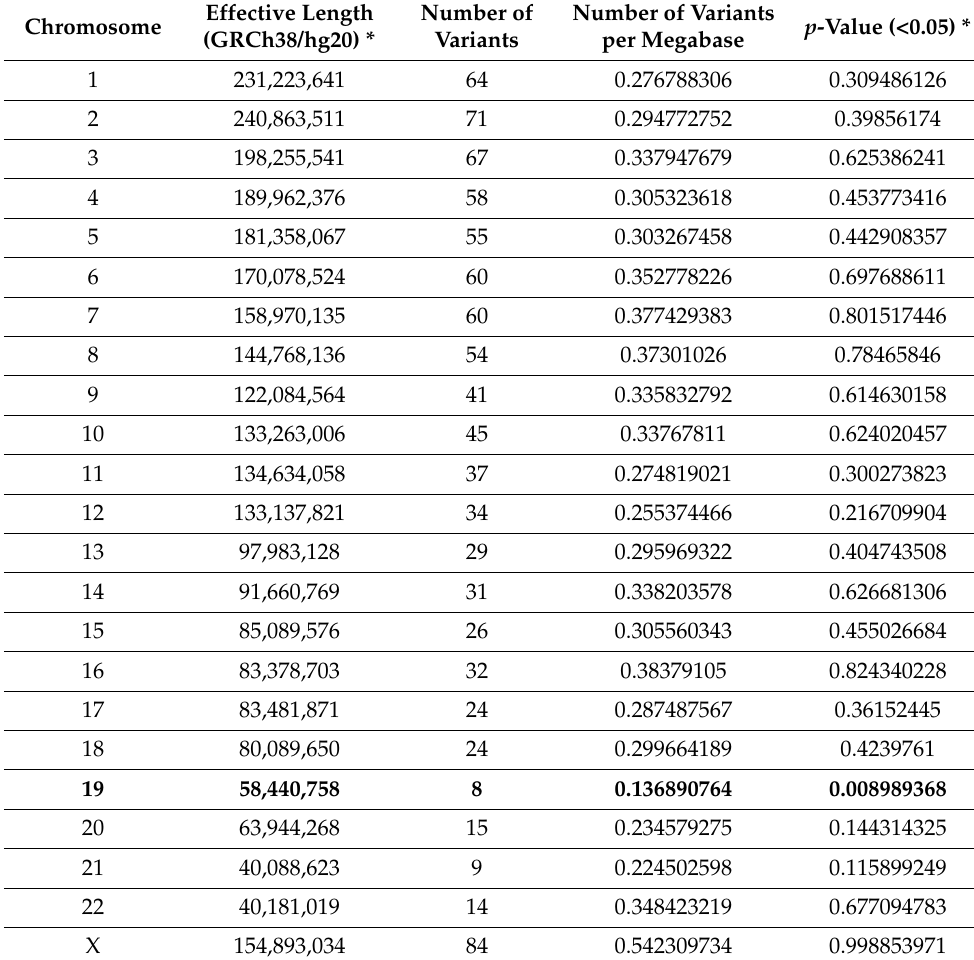
Table 3. Number of variants across